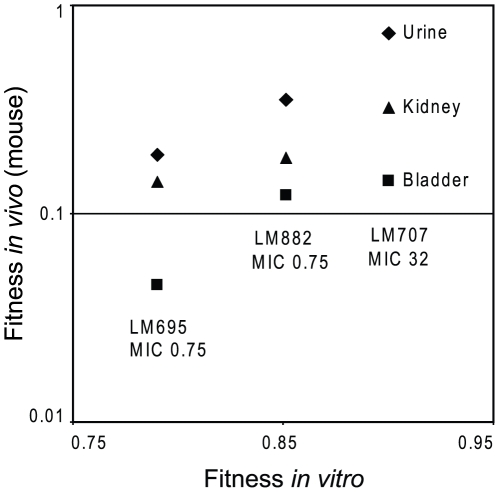
Fitness in vitro as a function of fitness in vivo in a mouse UTI model.Samples from urine, kidney, and bladder are illustrated with black diamonds, triangles, and squares, respectively. The addition of one extra resistance mutation to either LM695, or LM882 created LM707, with increased fitness in vitro and in vivo and an increase in MIC for ciprofloxacin from 0.75 to 32 µg/ml.